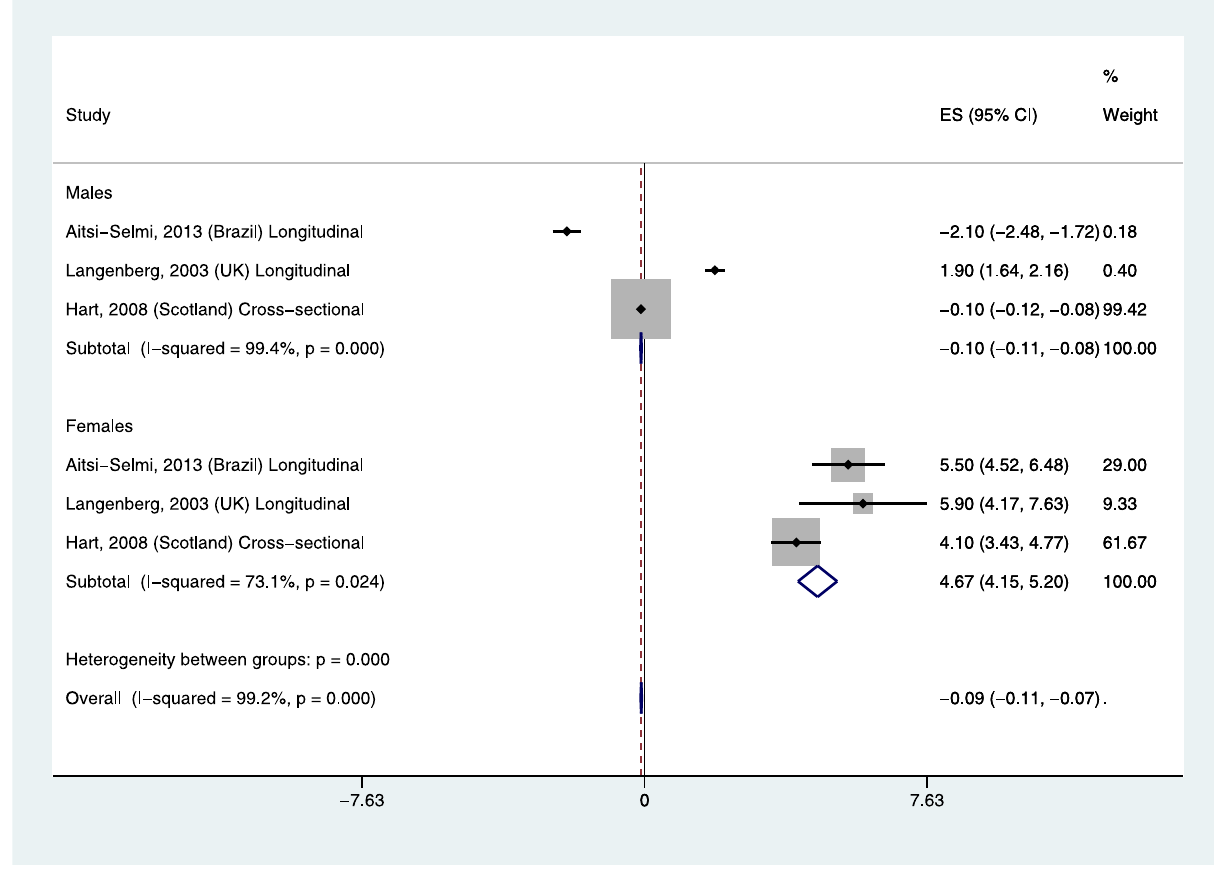
Fig 4. Mean difference in waist circumference by life course